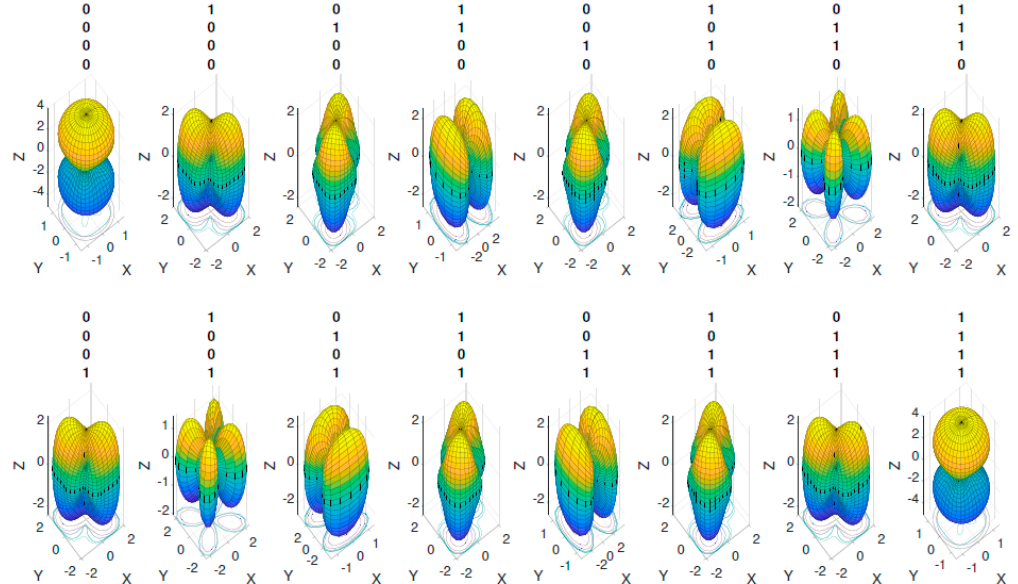
Figure 2. Radiation patterns for four antennas located at: [ λ /4,0 ] , [ 0, λ /4 ] , [ − λ /4,0 ] , and [ 0, − λ /4 ] with φ ON = 180 ◦ and φ OFF = 0 ◦